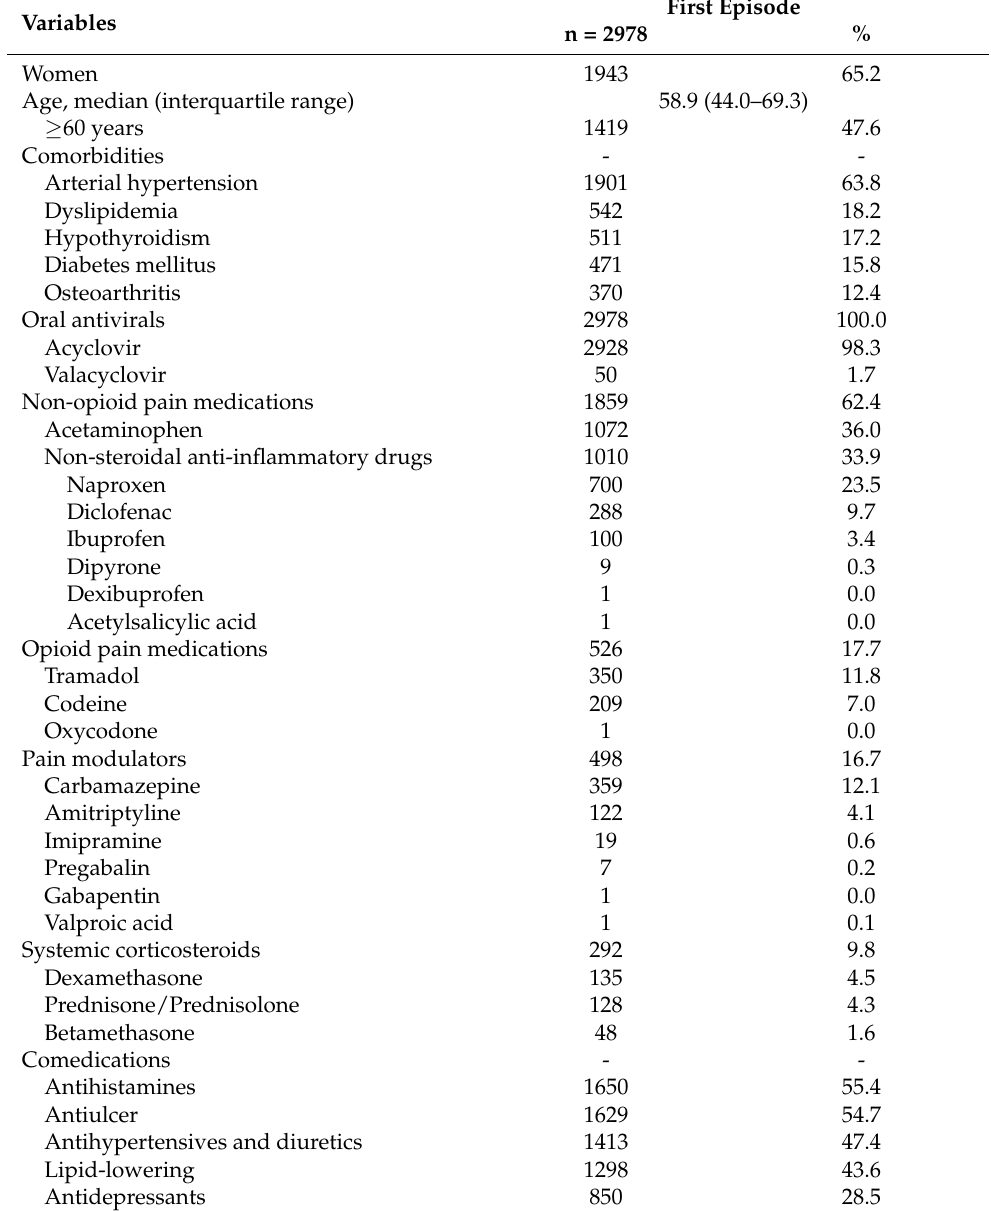
Table 1. Sociodemographic, pharmacological, and comorbidity characteristics of a group of patients with a first episode of herpes zoster,